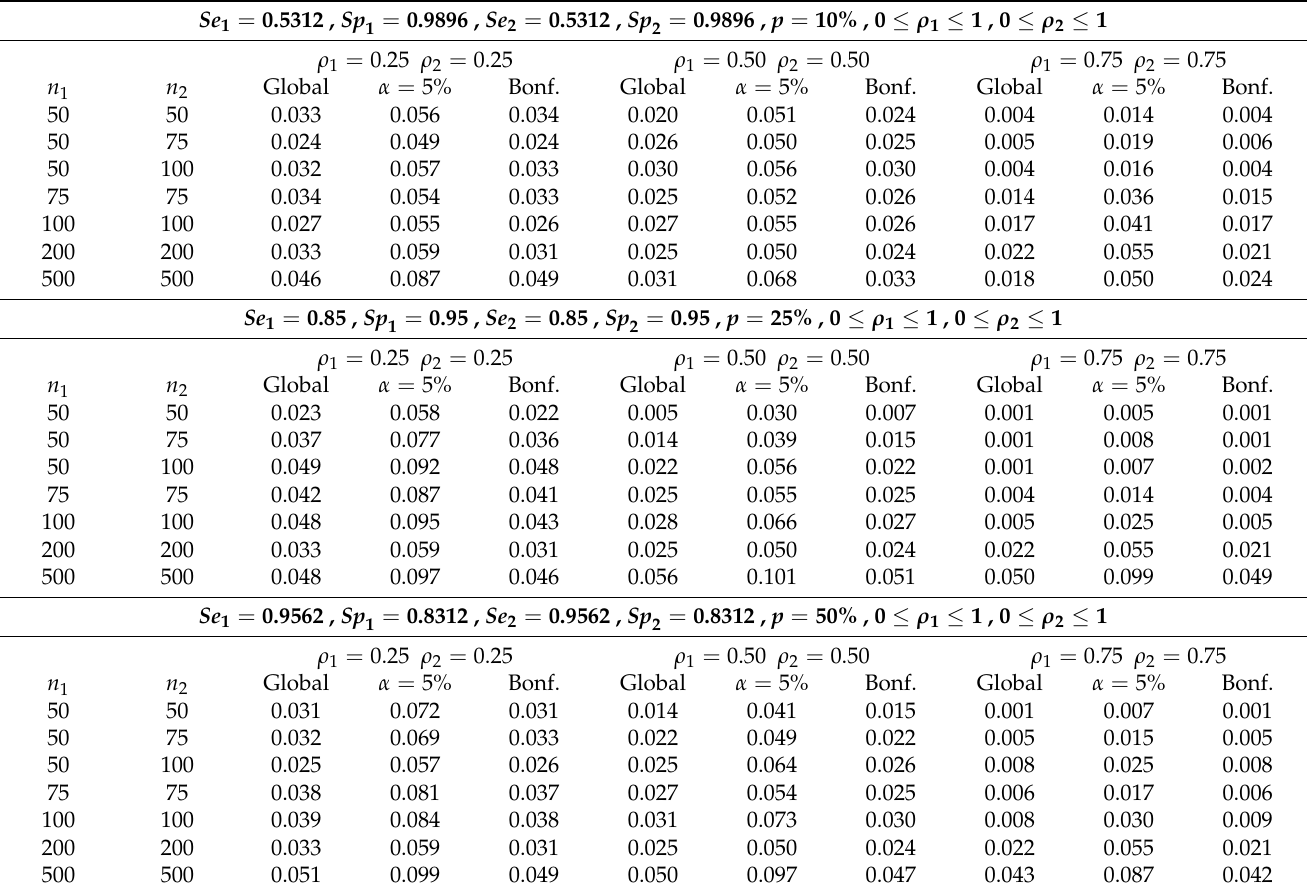
Table 3. Type I errors for PPV 1 = PPV 2 = 0.85 and NPV 1 = NPV 2 =